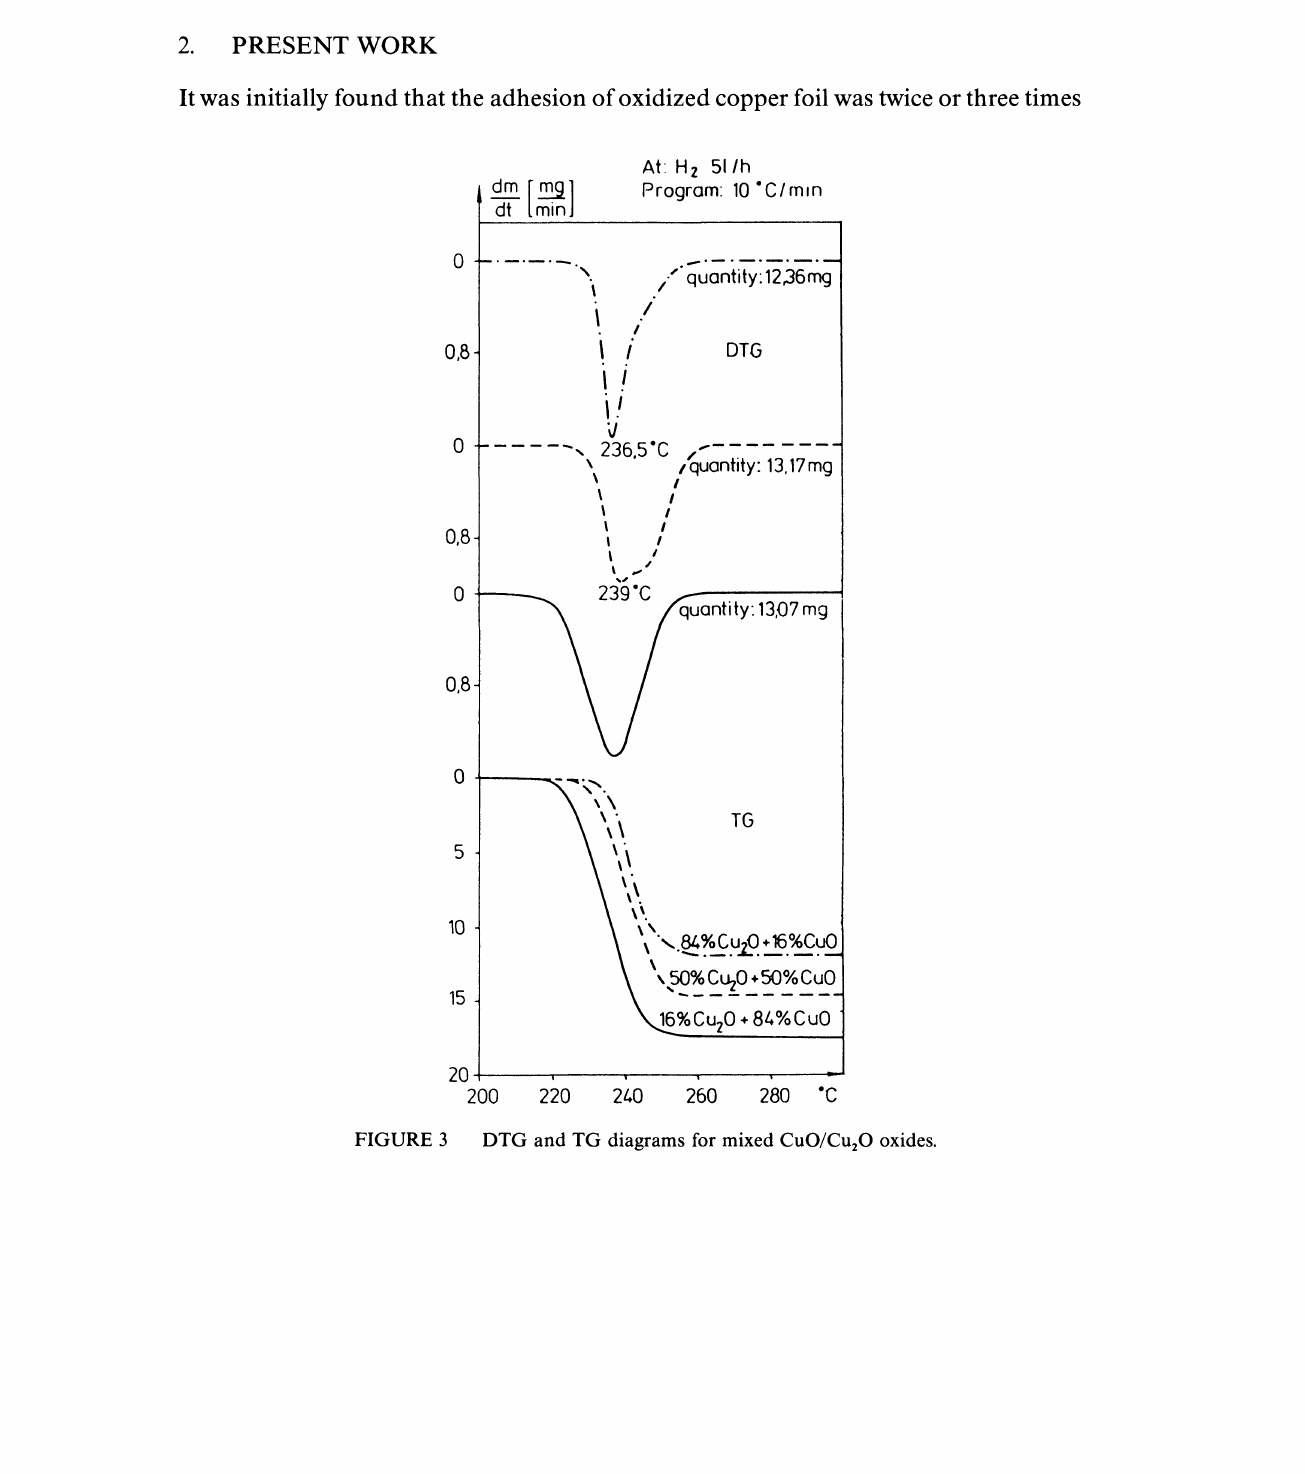
FIGURE 3 DTG and TG diagrams for mixed CuO/CuO